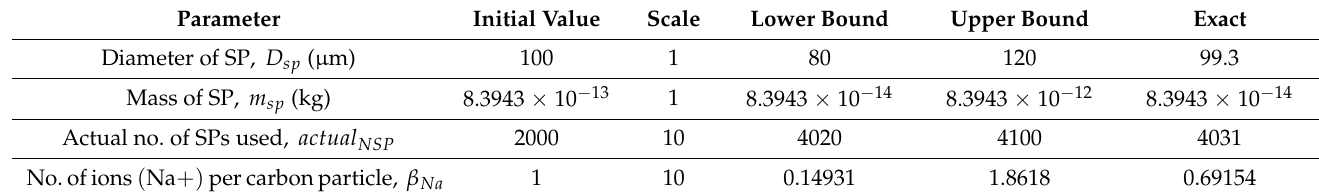
Table 2. Parameters used in optimization with their upper and lower bounds.